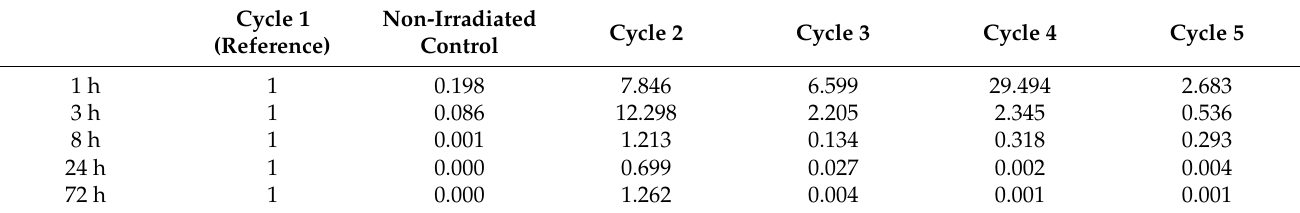
Table 2. Relative potency comparisons (LC 50 ) over a time course of UV exposure between CrleGV-SA samples from cycles 1 to 5 in surface concentration response bioassays against neonate T. leucotreta larvae using cycle 1 samples as the